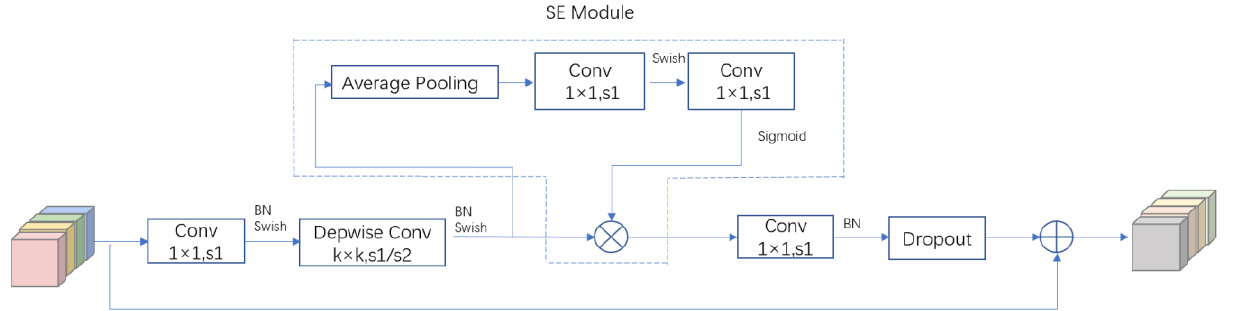
Figure 3. MBConv structure.